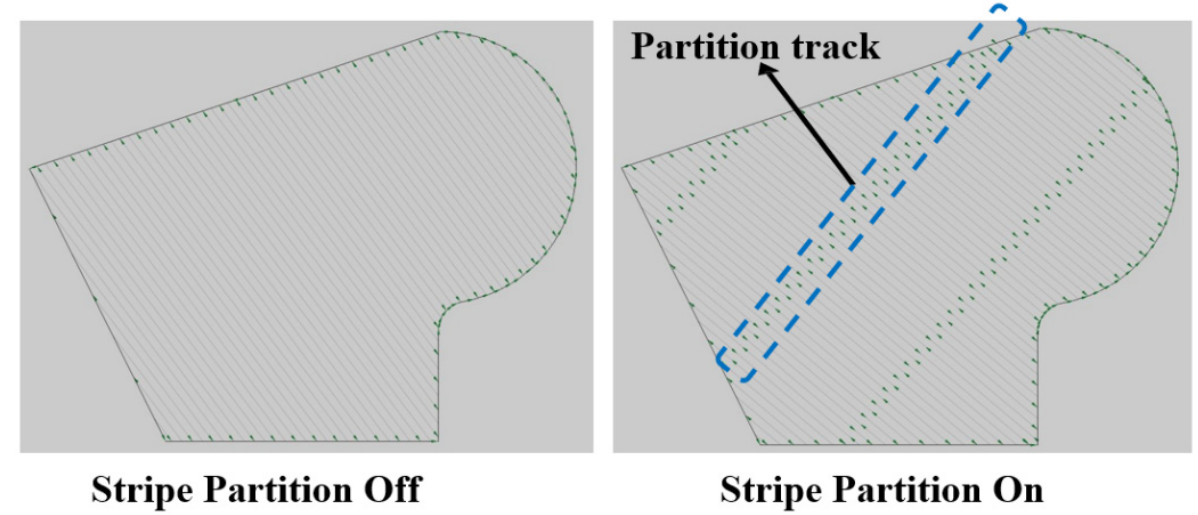
Figure 5. Schematic figure of stripe scanning strategy. Table 6. The Doehlert matrix and experimental results of up-facing surface roughness.